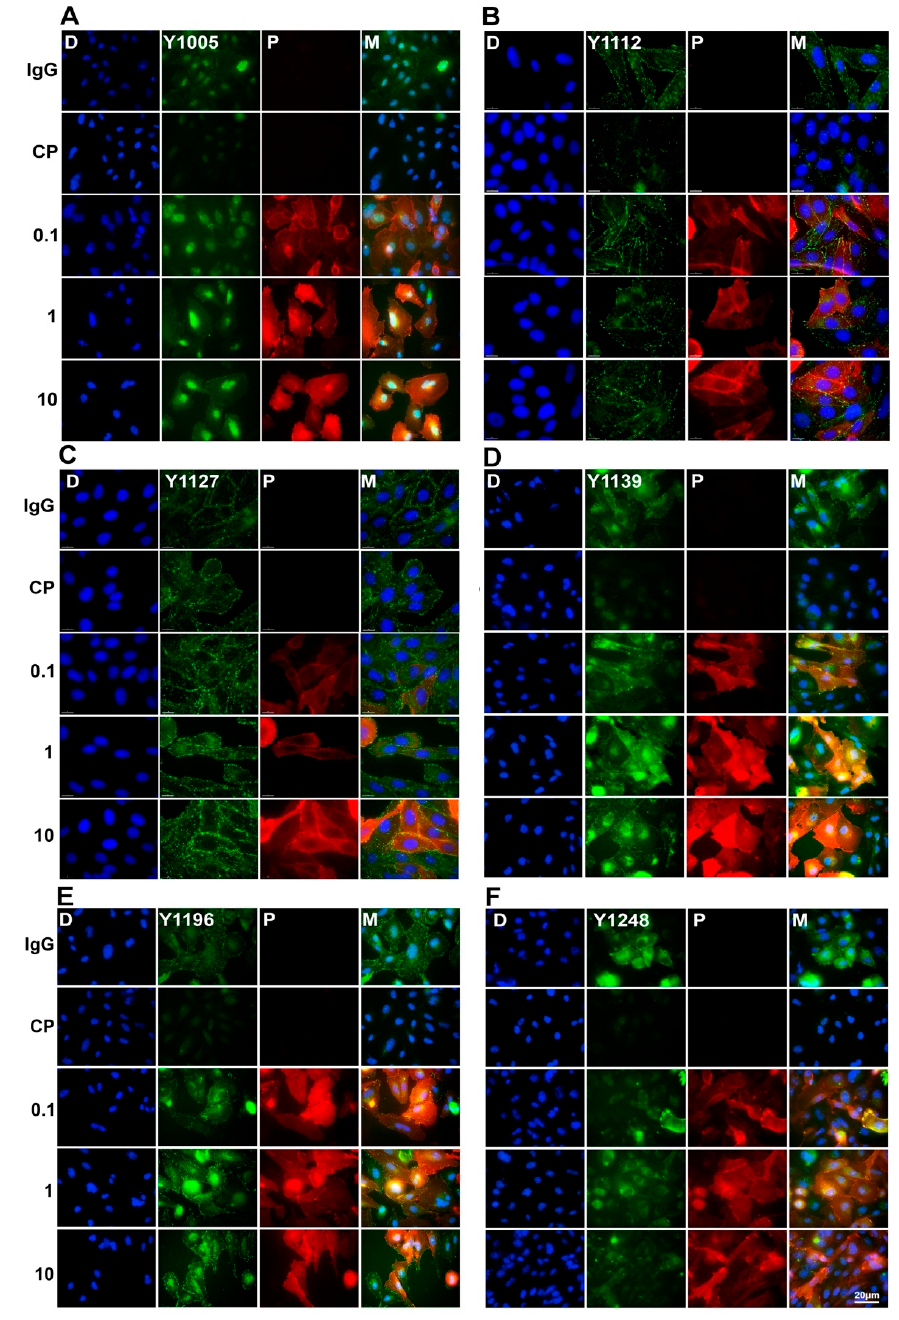
Figure 4. Double-immunofluorescence staining of pHER2 and pertuzumab in pertuzumab treated CHO-K6 cells. CHO-K6 cells were treated with 0.1, 1 and 10 µg/mL pertuzumab for 60 min then pHER2 at ( A ) pY1005 ( B ) pY1112, ( C ) pY1127, ( D ) pY1139, ( E ) pY1196, and ( F ) pY1248 HER2 (all green) and pertuzumab (red) were stained. Ten µg/mL human IgG and 20 µM CP-724714 (CP) were used as mock and HER2 positive controls, respectively.